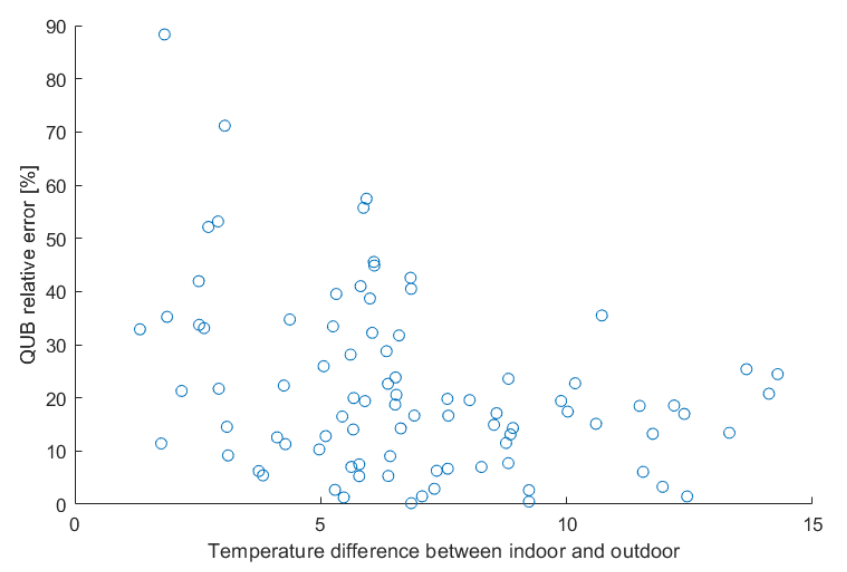
Figure 9. QUB error as a function of difference between outdoor and indoor temperature before the start of experiment.